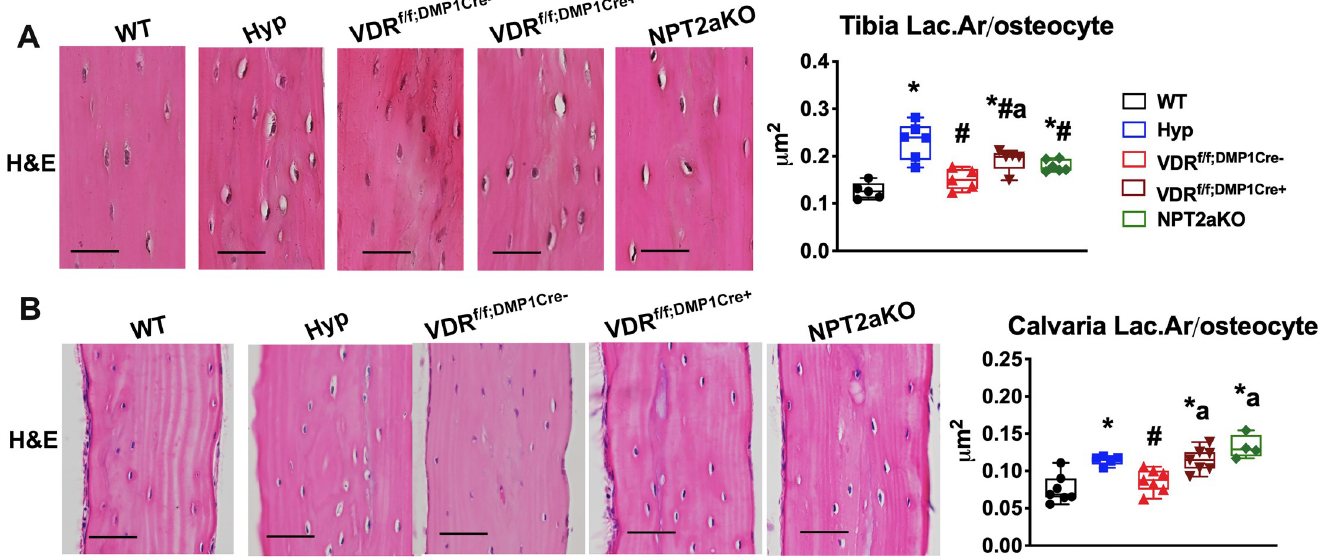
Fig 4. The tibial cortices and calvariae of VDR f/f;DMP1Cre+ and NPT2aKO mice have enlarged osteocyte lacunae. H&E stain of WT, Hyp, VDR f/f;DMP1Cre- , VDR f/f;DMP1Cre+ and NPT2aKO tibial cortices (d30) (A) and calvaria (d75) (B). Histomorphometric quantitation of osteocyte number and lacunar area normalized to the number of osteocytes (Lac.Ar/osteocyte) were performed proximal and contralateral to the tibiofibular junction and in the bilateral parietal bones. Data are representative of that obtained from at least 5 mice per genotype, with each group including 2–4 mice of either sex. Scale bar = 20 μ m in (A). Scale bar = 40 μ m in (B). � p < 0.05 vs WT, # p < 0.05 vs Hyp, a p < 0.05 vs VDR f/f;DMP1Cre- .